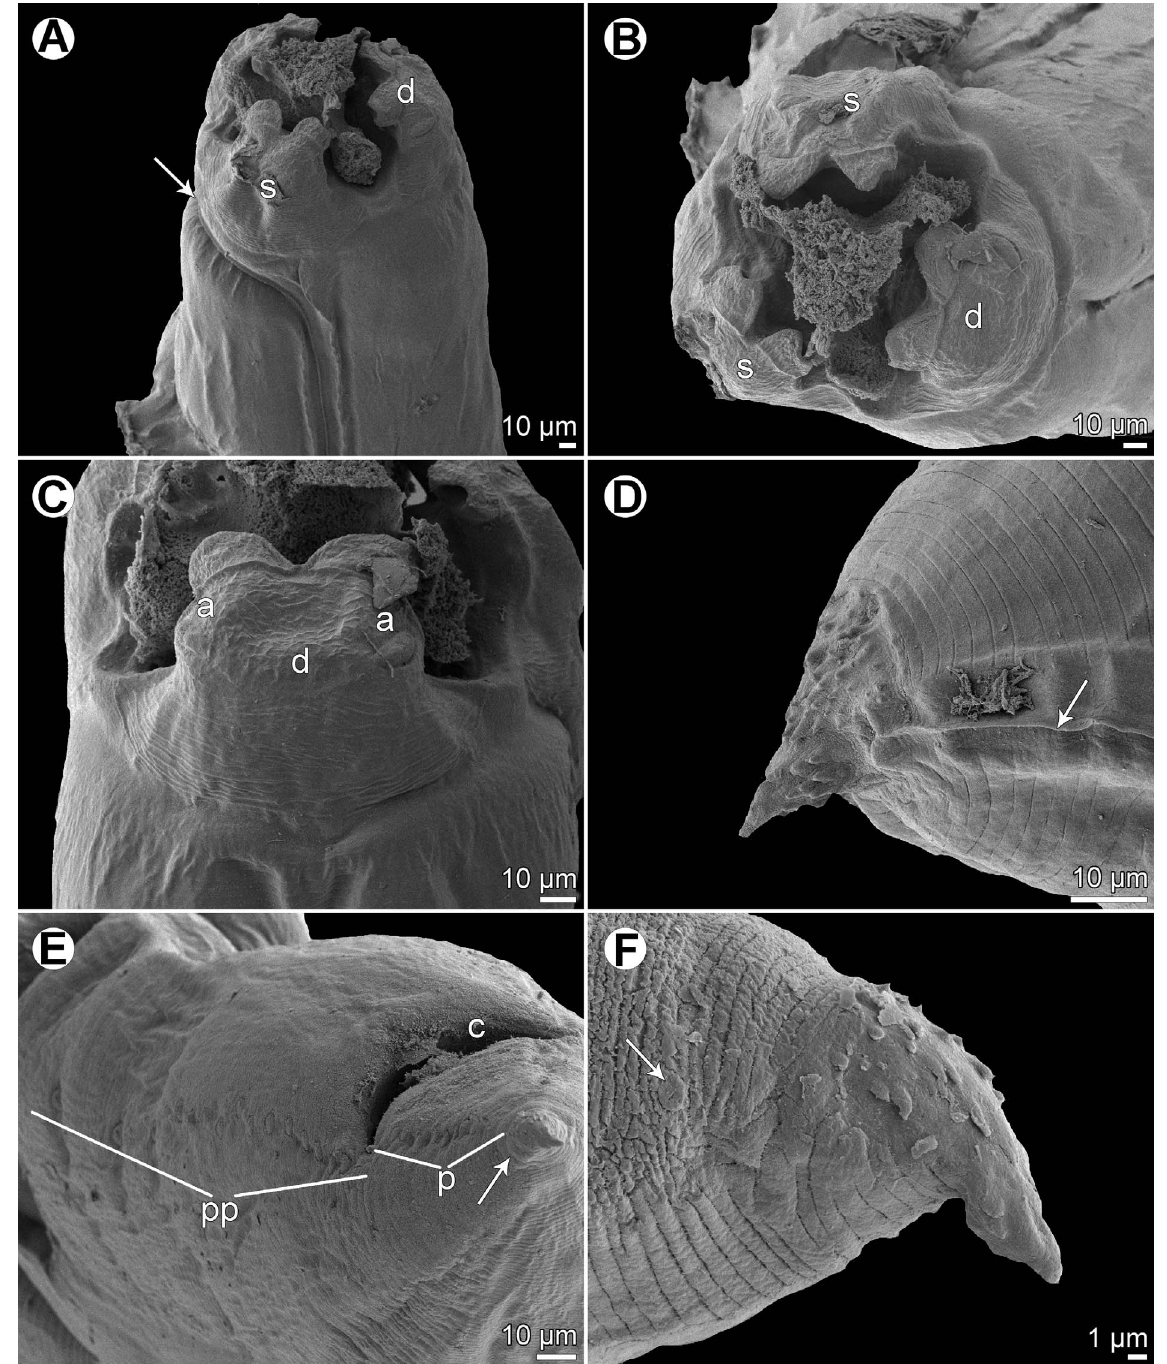
Figure 2. Raphidascaris ( Ichthyascaris ) spinicauda n. sp., scanning electron micrographs. (A) Cephalic end of female, sublateral view (arrow indicates ventral connection of lateral alae); (B) cephalic end of female, apical view; (C) dorsal lip, dorsal view; (D) tail tip of female, lateral view (upper side is ventral) (arrow indicates lateral ala); (E) posterior end of male, ventrolateral view (arrow indicates phasmid); (F) tail tip of male, lateral view (upper side is ventral) (arrow indicates phasmid). (a) Double cephalic papilla; (c) cloaca; (d) dorsal lip; (p) postanal papillae; (pp) preanal papillae; (s) subventral